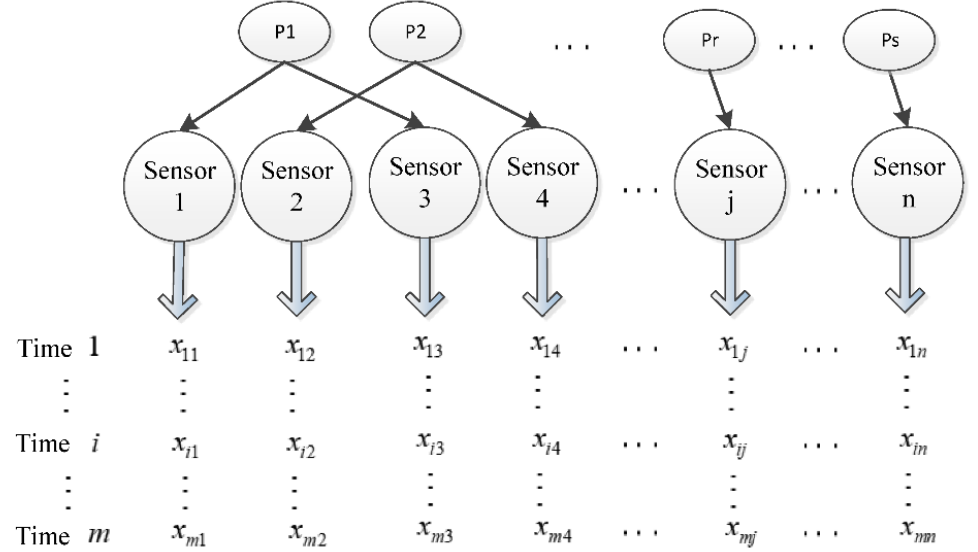
Figure 1. Schematic diagram of telemetry data acquisition.